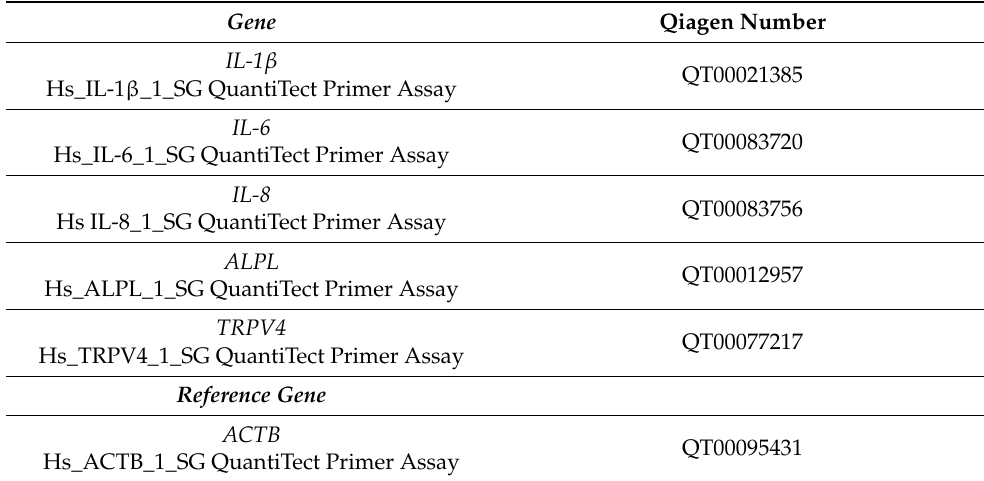
Table 3. List of gene Qiagen primers used to study gene expression profiling. Their expression was normalized to the b-actin reference